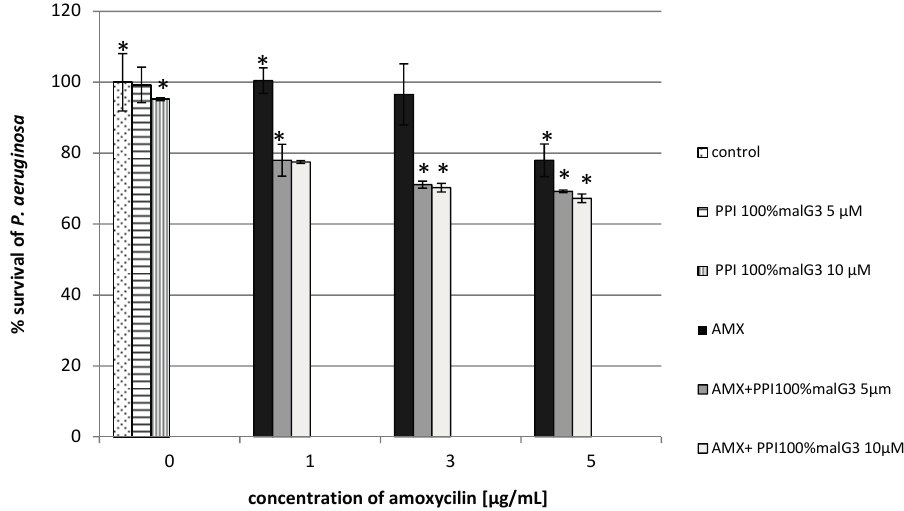
Figure 3. Growth of P. aeruginosa after 24 h incubation with poly(propylene imine) dendrimers with a surface modified by attaching maltose in 100% (PPI 100%malG3 or/and amoxicillin. Each bar represents and the mean and SD of n ≥ 3 wells from three independent experiments. The comparison was made using one-way analysis of Student’s t- test. * p < 0.05 vs. control